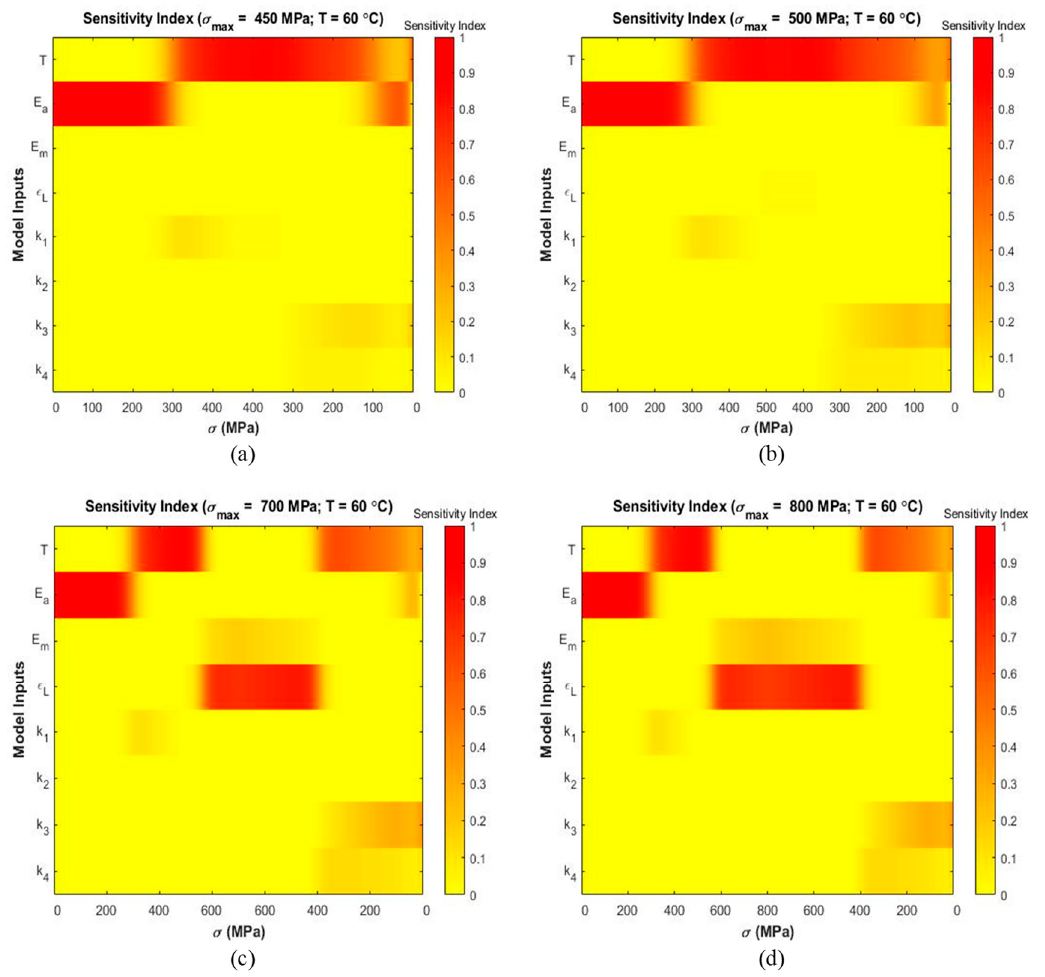
Figure 8. Sensitivity index distribution during loading and unloading based on eFAST sensitivity analysis at simulated temperatures (the corresponding stress values are shown in horizontal axis and the inputs are shown in vertical axis): ( a ) T = 60 ◦ C, σ max = 450 MPa ( b ) T = 60 ◦ C, σ max = 500 MPa ( c ) T = 60 ◦ C, σ max = 700 MPa ( d ) T = 60 ◦ C, σ max = 800 MPa.